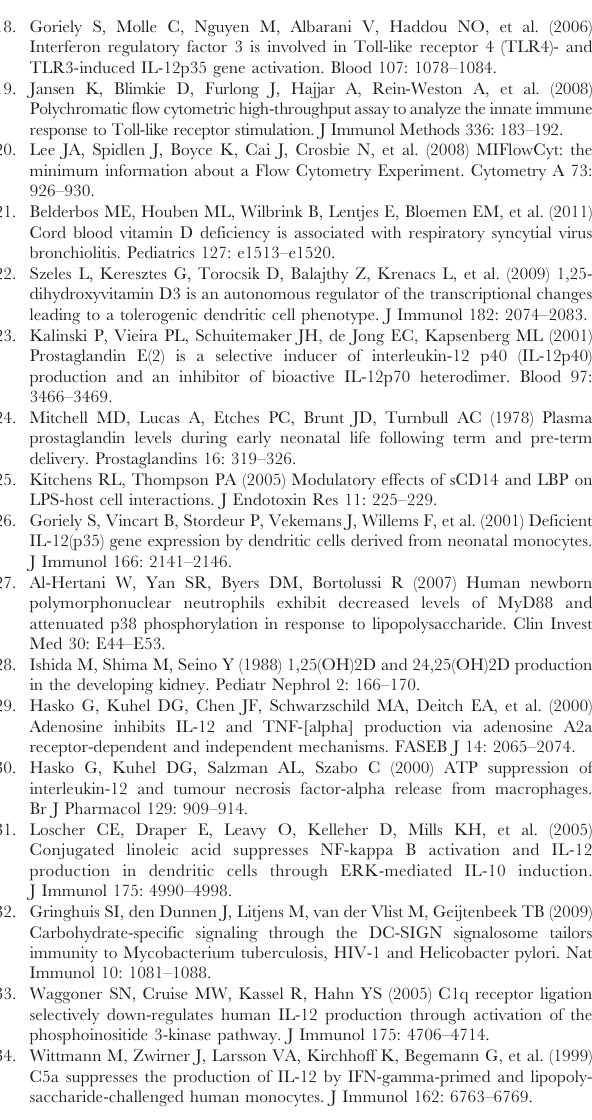
Figure S3 Effect of vitamin D and PGE 2 on